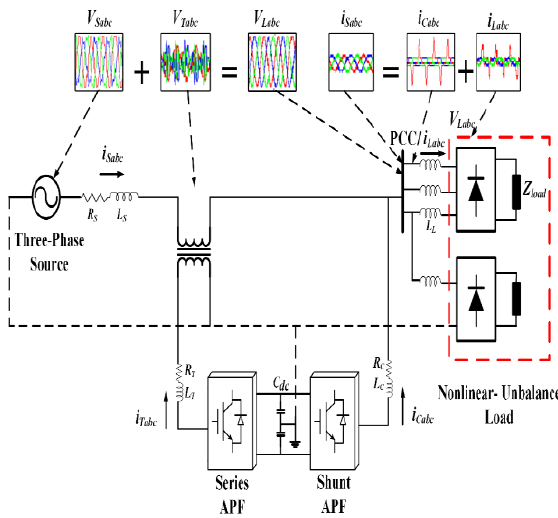
Figure 1. The basic structure of unified power quality conditioner (UPQC).